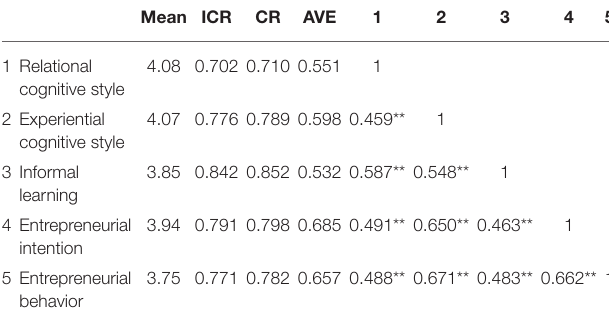
TABLE 2 | Mean, SD, correlation, reliability, and validity.